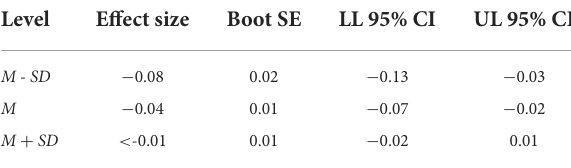
TABLE 4 Results for conditional indirect effect across levels of psychological